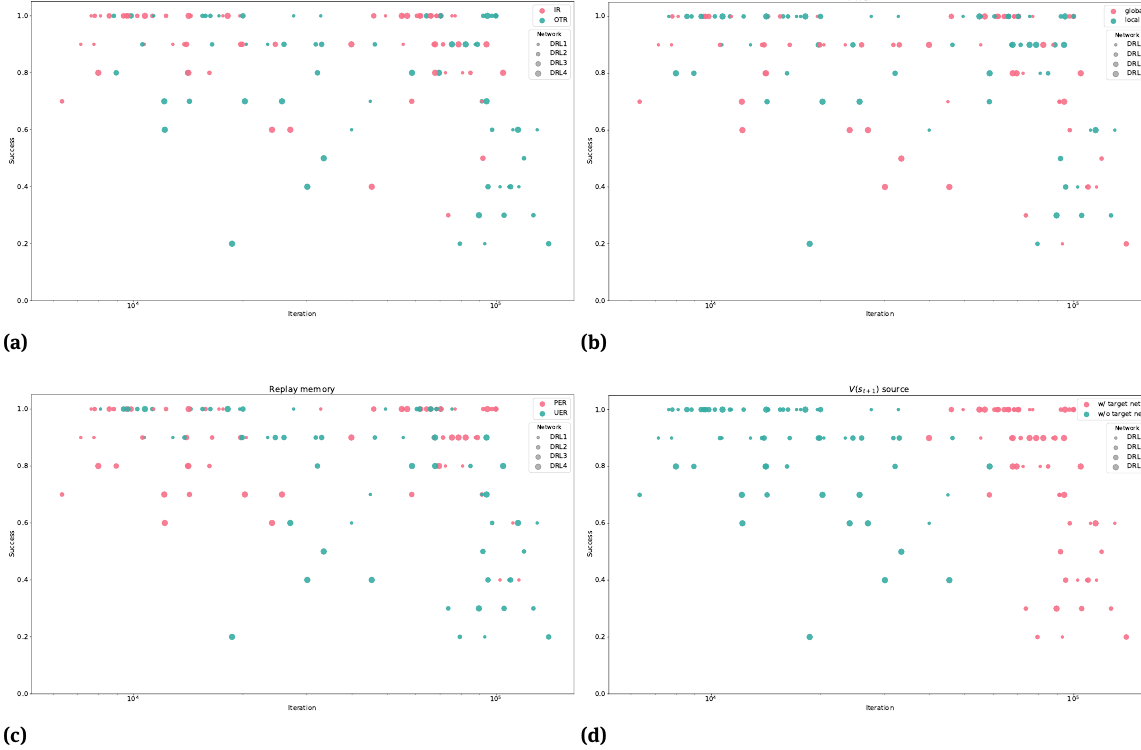
Figure 5: Scatter plot of the agents based on their success rate and number of iterations to learn the given tasks. Each circle in the figures represents an agent with a unique configuration and task which were trained 10 times. The y-axis shows the success rate of the agent out of 10 trials and the x-axis (log scale) shows the first iteration which agent could solve the task in the test mode (no exploration). The dots at the top-left corner in each plot represent the agents with the best performance. The agents are separated based on (a) reward type, (b) V ( s t +1 ) estimation, (c) replay memory, and (d) V ( s t +1 ) source. It can be seen that the results are independent of the size of the network (indicated by the size of the